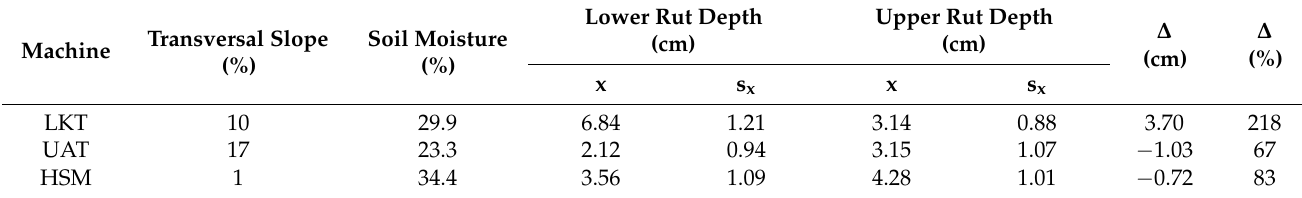
Table 6. Average depths of ruts measured at individual plots after the 40th